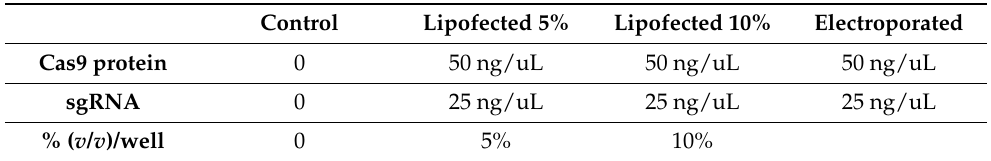
Table 1. Experimental conditions of the different groups used to evaluate the influence of the concentration of LRNP complexes in the medium.